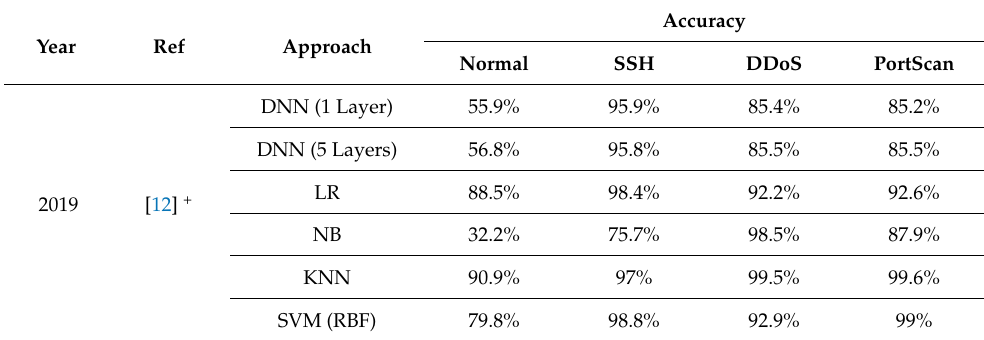
Table 2. CICIDS2017 recent papers performance summary (2).